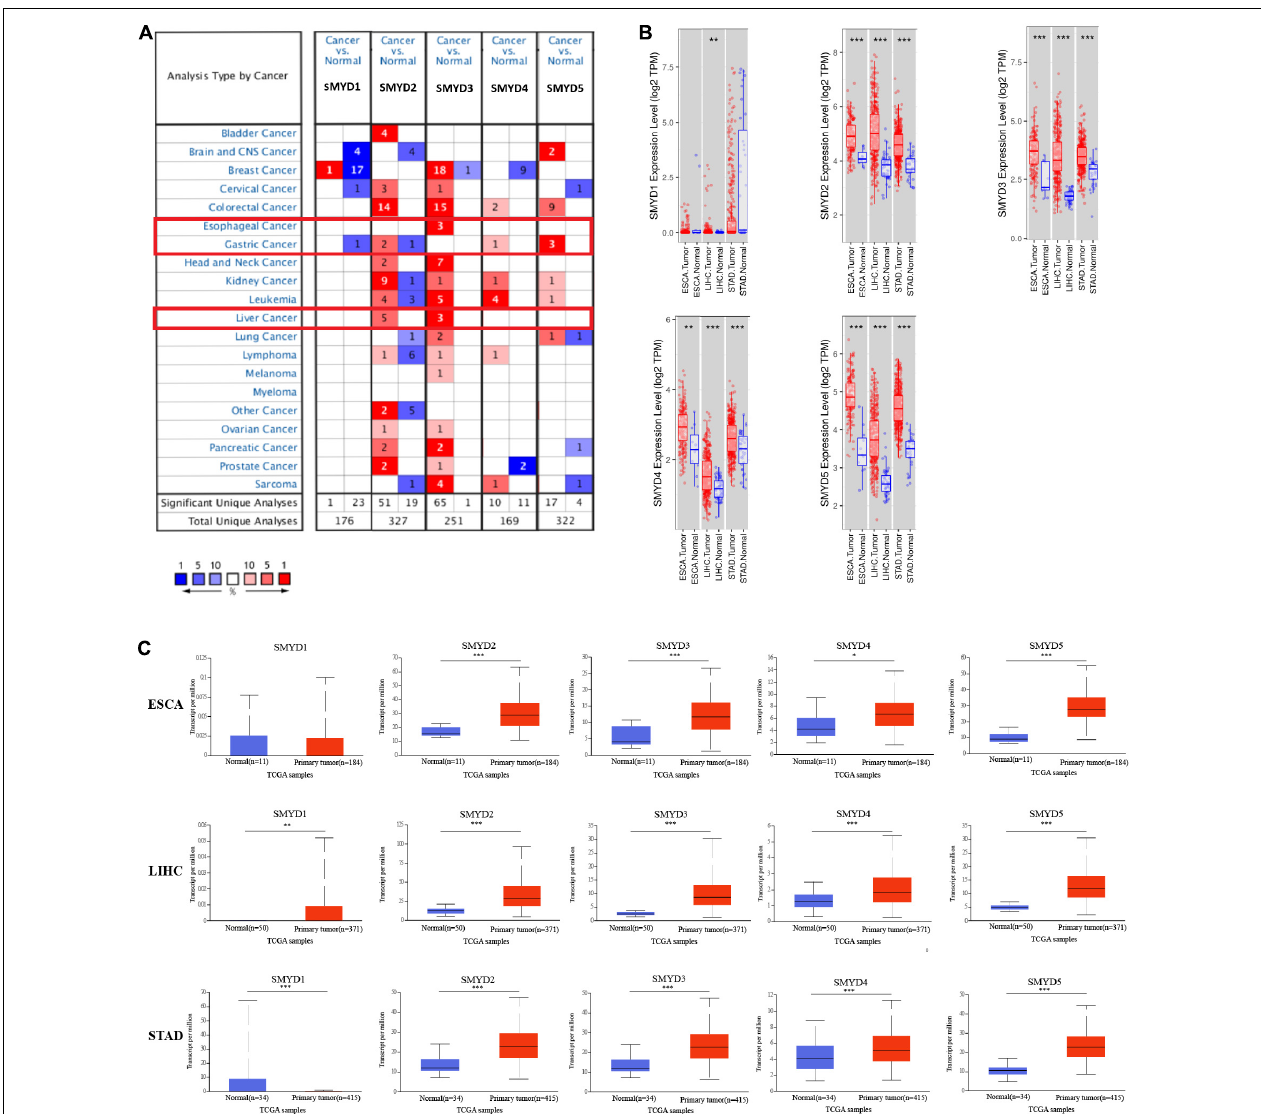
FIGURE 1 | The mRNA expression levels of SMYD family members in 20 types of cancers (Oncomine). The graph shows the numbers of datasets with statistically significant mRNA high expression (red) or low expression (blue) of the target gene. The threshold was designed with following parameters: P -value of 0.01 and fold change of 1.5, and data type of mRNA (A) . The mRNA expression levels of SMYD family members in ESCA, LIHC, STAD (red), and normal tissues of esophagus, liver and stomach (blue) (Timer) ( ∗ P < 0.05, ∗∗ P < 0.01, ∗∗∗ P < 0.001) (B) . The mRNA expression levels of SMYD family members in ESCA, LIHC, STAD (red), and normal tissues of esophagus, liver, and stomach (blue) (UALCAN) ( ∗ P < 0.05, ∗∗ P < 0.01, ∗∗∗ P < 0.001) (C)